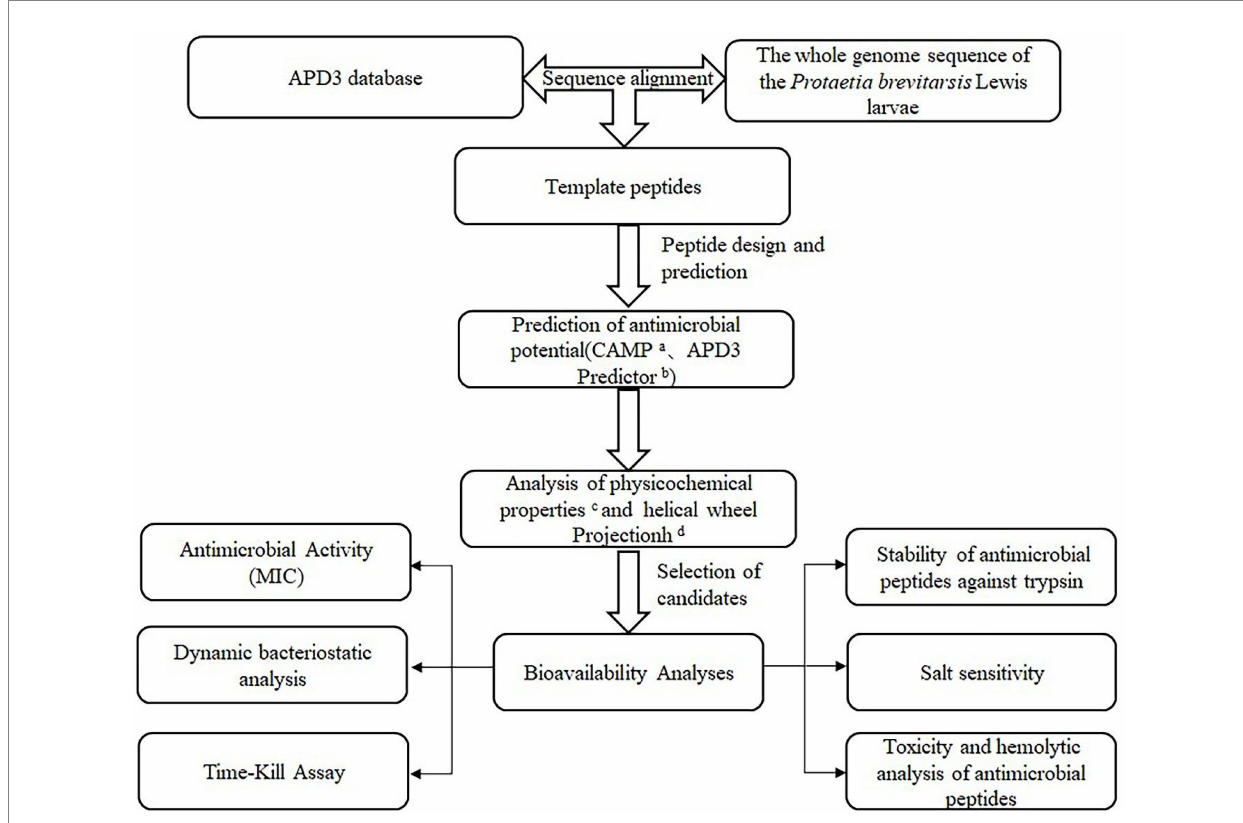
FIGURE 1 Strategistic diagram of the methodology used to select potential antibacterial peptides in the P. brevitarsis Lewis. a CAMP (http://www.camp.bicnirrh.res. in/). b APD3 Predictor (http://aps.unmc.edu/AP/prediction/prediction_main.php). c ExPASy–ProtParam (http://web.expasy.org/protparam/). d Heliquest